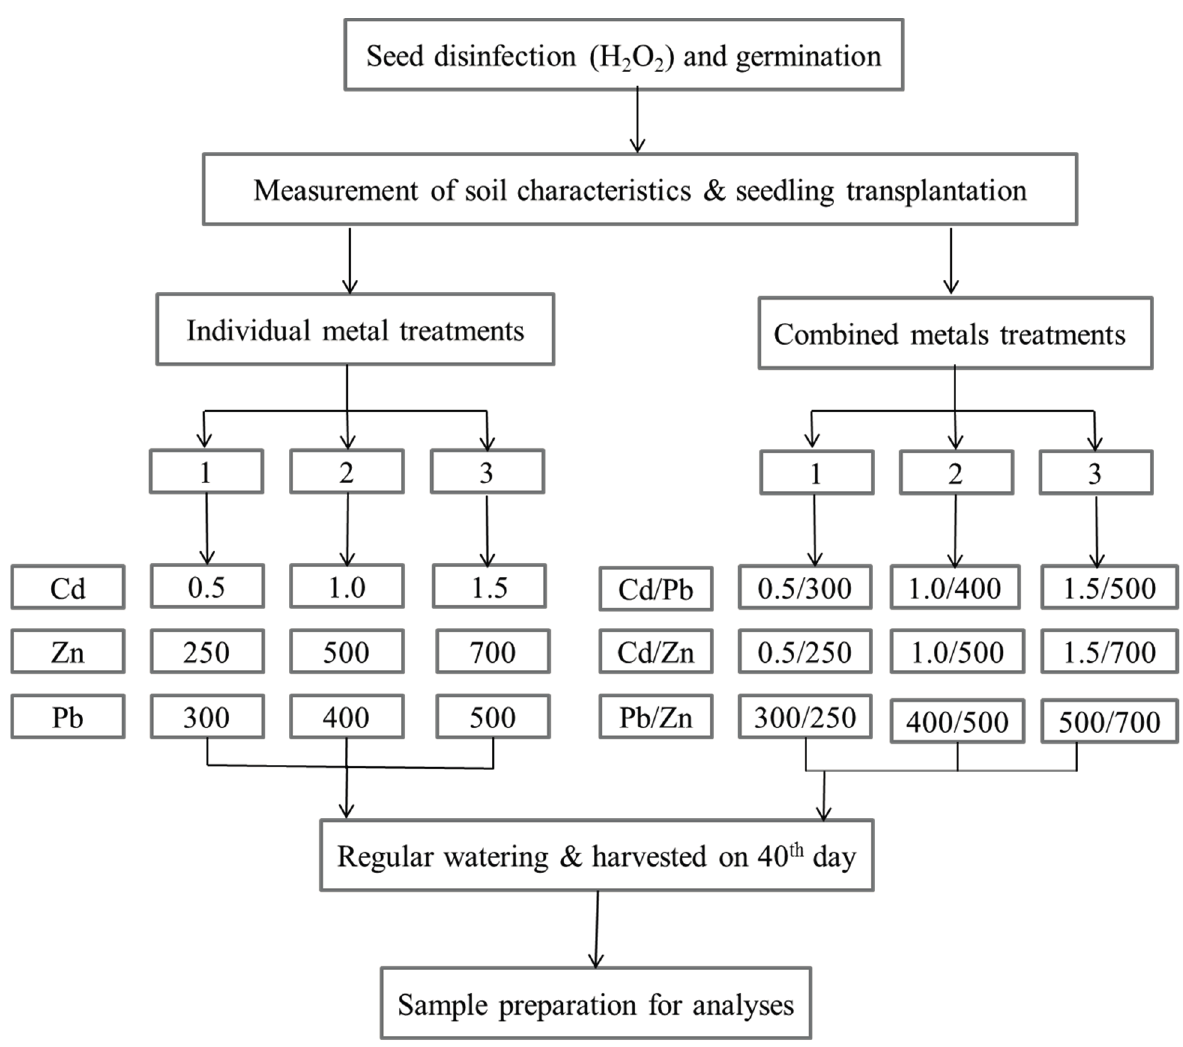
Figure 1. Diagrammatic representation of experimental design and procedure (Cd, cadmium; Pb, lead; Zn,